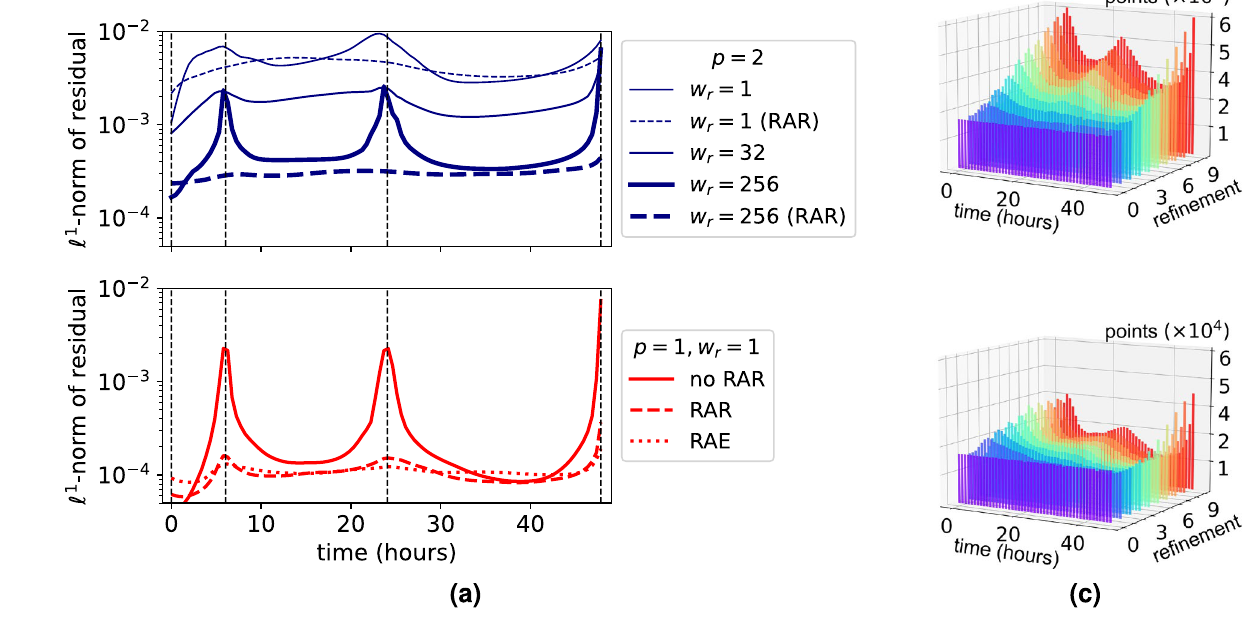
Figure 5. Adaptive training point refinement is needed to fulfill the PDE in all timepoints. ( a ) Average PDE residual in (cid:31) P over time for different optimization schemes. Vertical lines (dashed) indicate the times where data is available. In all cases, the learning rate decays exponentially from 10 − 3 to 10 − 4 . ( b , c ) Distribution of PDE points during training with RAR ( b ) and RAE ( c ). Starting from a uniform distribution of points (in time), more points are added at 7, 24 and 46 h where data is available.